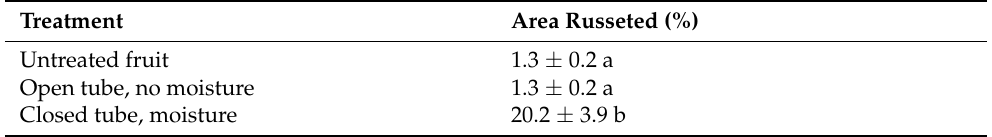
Table 1. Effect of exposure to surface moisture on the russeting of fruit of mango cv. apple. Fruit was exposed to surface moisture by attaching a short plastic tube filled with distilled water to the fruit surface for 16 d at 53 days after full bloom. Untreated fruit (control) and fruit with an open tube attached (open tube, no water) served as controls. Tubes were removed after 16 d and the fruits left to grow to maturity. Russeting was estimated by expressing the area russeted as a percentage of the area of the footprint of the tube. N = 18–20.